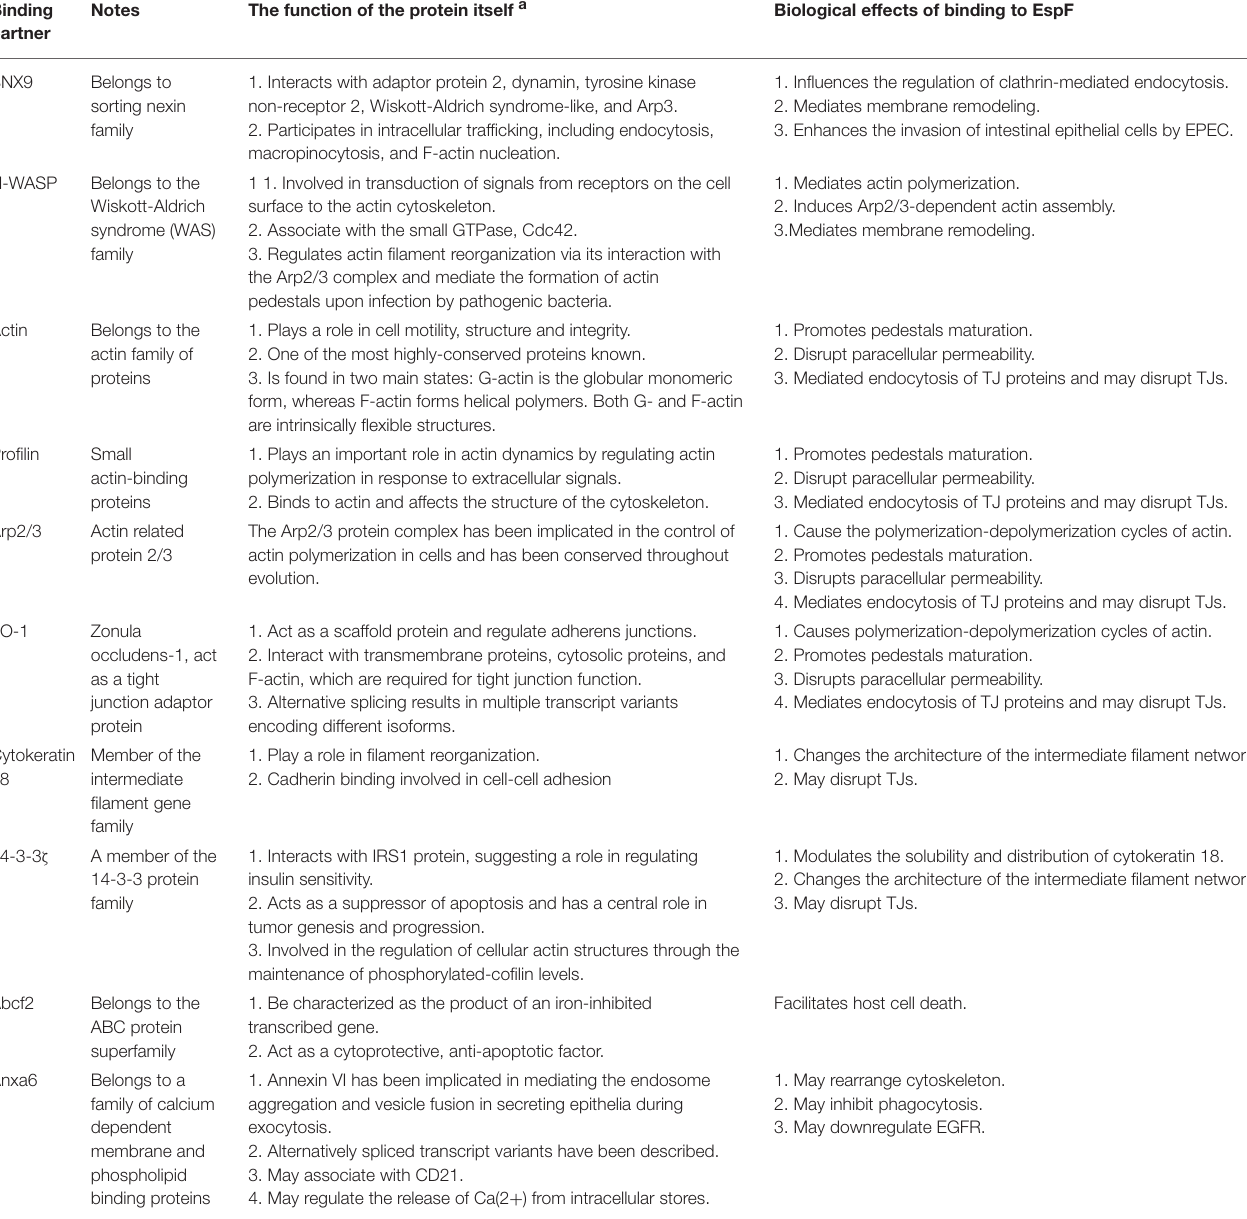
TABLE 1 | EspF host binding partners and their biological